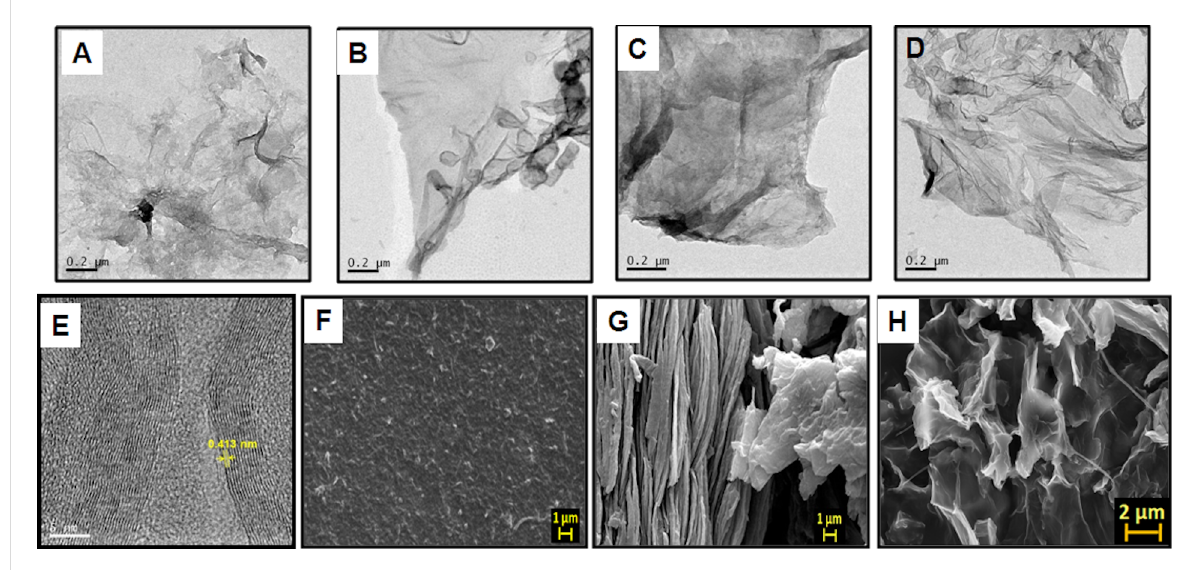
Figure 3: (A) TEM images of as-synthesized GO, ERGO synthesized in different electrolytes: (B) PBS pH 4.5, (C) pH 7, and (D) pH 9.6. (E) HRTEM image of ERGO in PBS pH 4.5. (F) SEM micrographs of as-synthesized GO, (G) ERGO in PBS pH 4.5 and (H) FESEM of ERGO in PBS pH 4.5 at dif- ferent